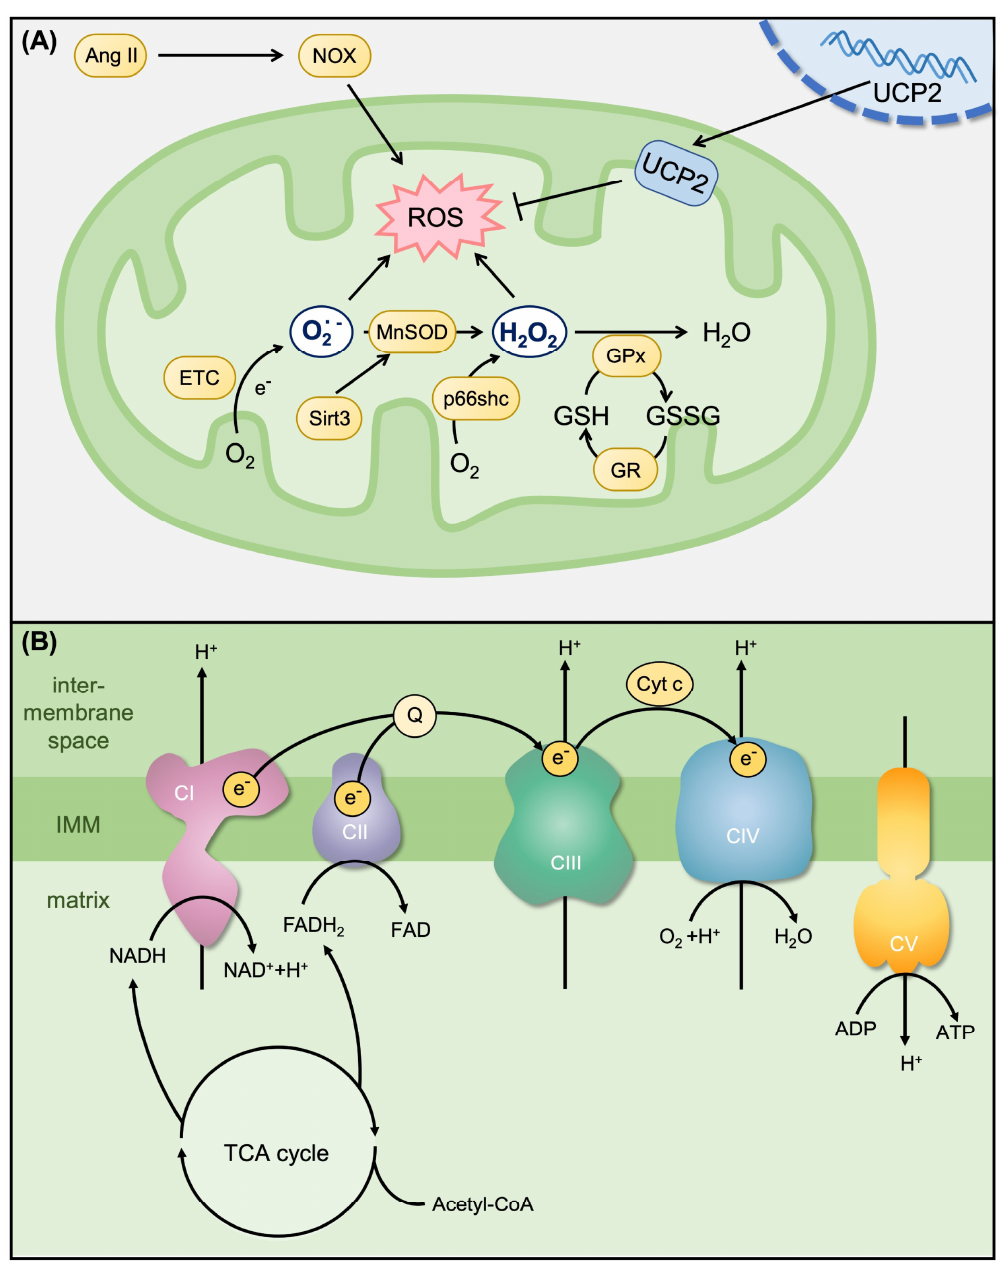
Figure 4. Mitochondrial antioxidant system and OXPHOS. ( A ) Mitochondrial antioxidants and ROS production. Mitochondria are the major source of superoxide (O 2 ˙ − ) in aerobic organisms. ETC generate ATP and results in O 2 ˙ − production, which is converted to hydrogen peroxide (H 2 O 2 ) by manganese-superoxide dismutase (MnSOD), and then converted to H 2 O by glutathione peroxidase (GPx). Uncoupling protein-2 (UCP2) also plays a key role in the control of intracellular oxidative stress. ( B ) Mitochondrial ETC and OXPHOS. Electrons (e − ) are transferred from reduced nicotinamide adenine dinucleotide (NADH) to oxidized form (NAD + ) in complex I (CI) or from flavin adenine dinucleotide (FADH 2 )-containing enzymes complex II (CII) to reduce CoQ10 (Q). The electrons are then transferred to complex III (CIII, bc1 complex) and cyt c. Finally, H 2 reacts with O 2 to yield H 2 O in complex IV (CIV). Complex V (CV, ATP synthase) synthesizes ATP from ADP, which is driven from the proton (H + ) gradient (produced by CI, CIII and CIV). In addition, the NADH and FADH 2 for OXPHOS are produced by both fatty acid β -oxidation and the tricarboxylic acid (TCA) cycle. Acetyl-CoA is generated from fatty acids ( β -oxidation), amino acids or pyruvate (glycolysis) for initial mitochondrial TCA cycle